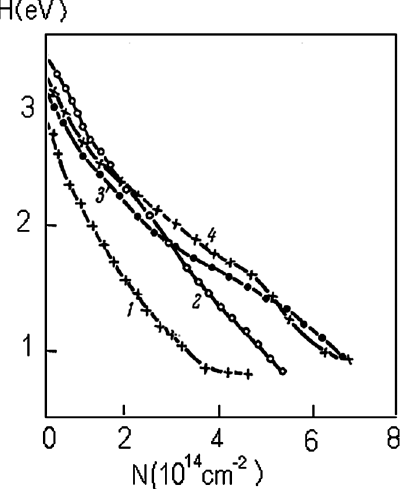
FIG. 10. Dependence of desorption energy H on surface cesium concentration N for different W crystalline surfaces